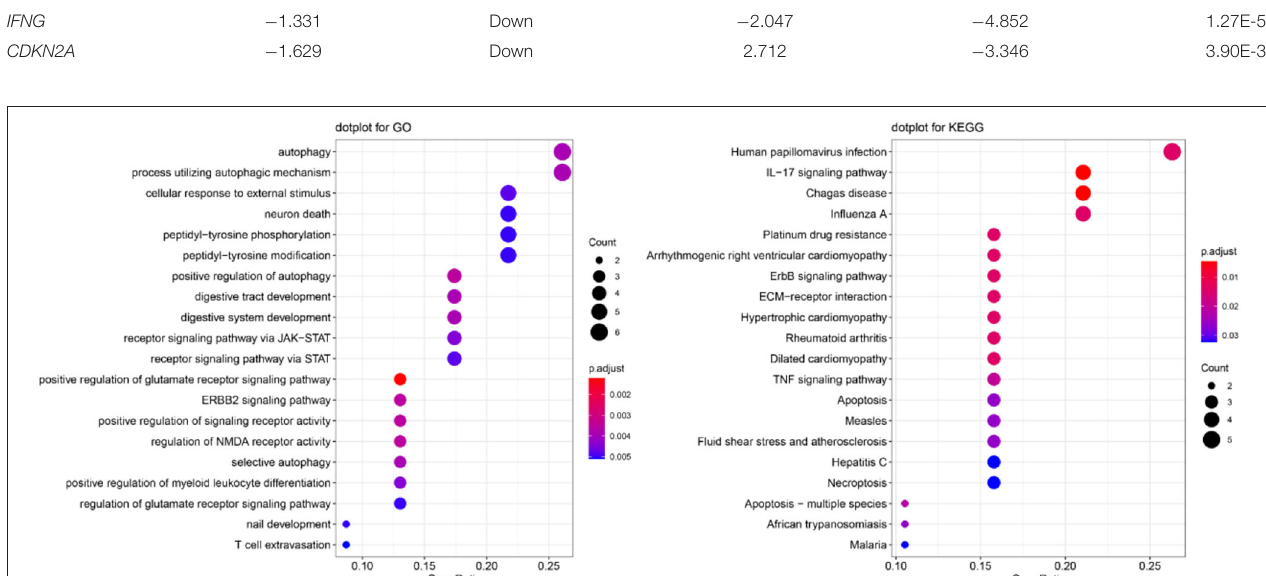
Genetic Risk Score Analysis The Kaplan-Meier survival analysis was utilized to evaluate and the overall survival time in TCGA OSCC data set ( Supplementary Figure 3 ). Four genes ( CDKN2A , NKX2-3 , NRG3 , and FADD ) were significantly associated with